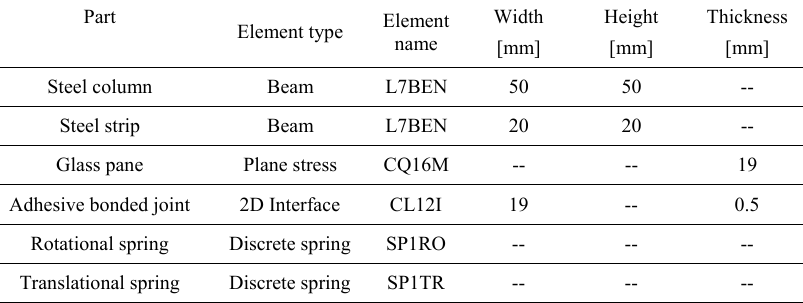
Table 3: Element types and geometrical data.